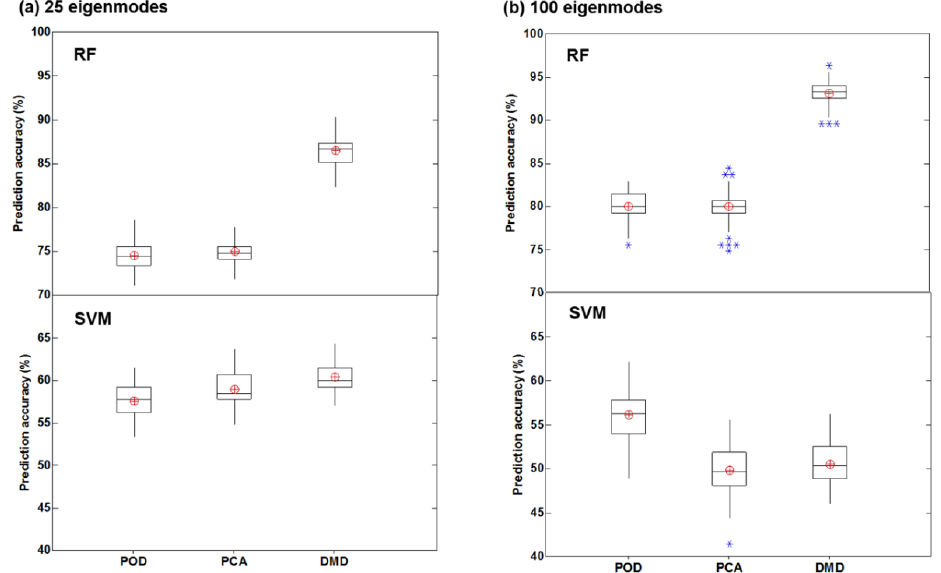
Figure 16. Classification accuracy of the five stages of an asthmatic bronchiole (A0-4) by retaining a varying amount of eigenmodes: ( a ) 25 and ( b ) 100. Various combinations between feature extraction (POD, PCA, DMD) and classification (SVM and RF) algorithms were compared. The asterisks in ( b ) are outliers.